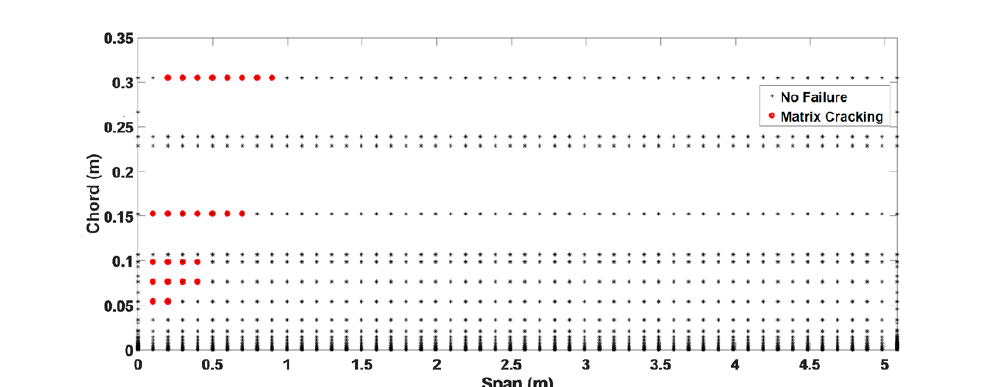
Figure 9. Fail nodes at 15